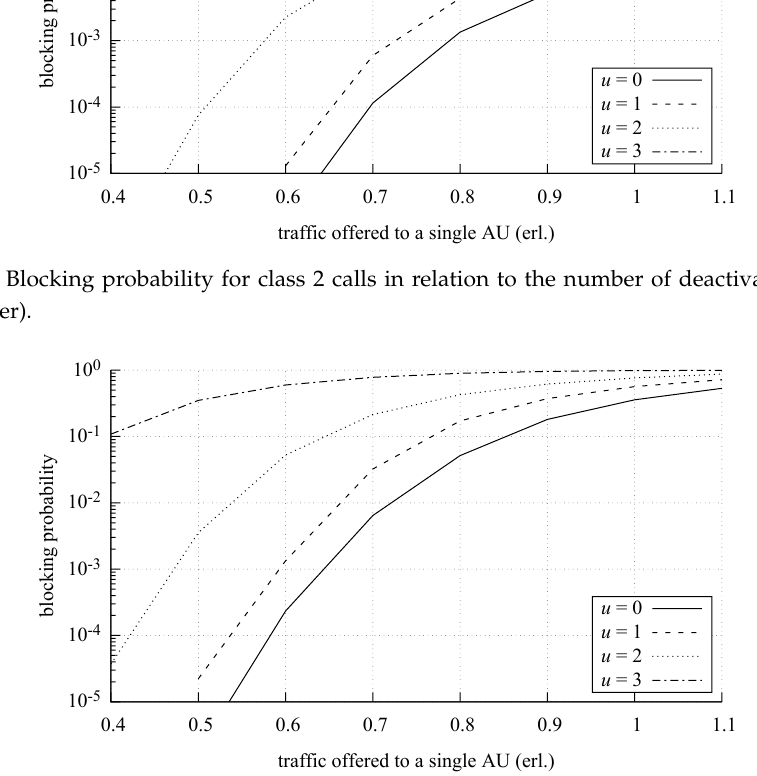
Figure 12. Blocking probability for class 3 calls in relation to the number of deactivated switches ( u